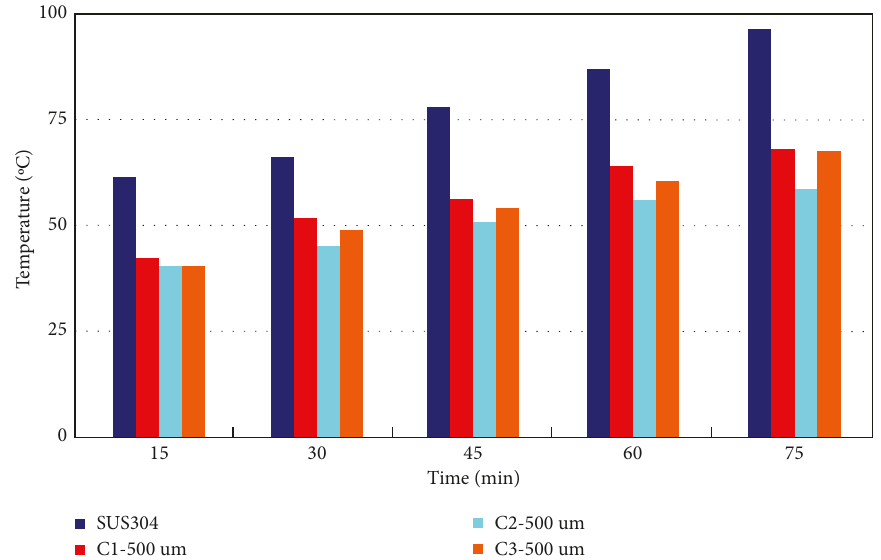
Figure 7: The temperature change analysis diagram of 500 μ m C.